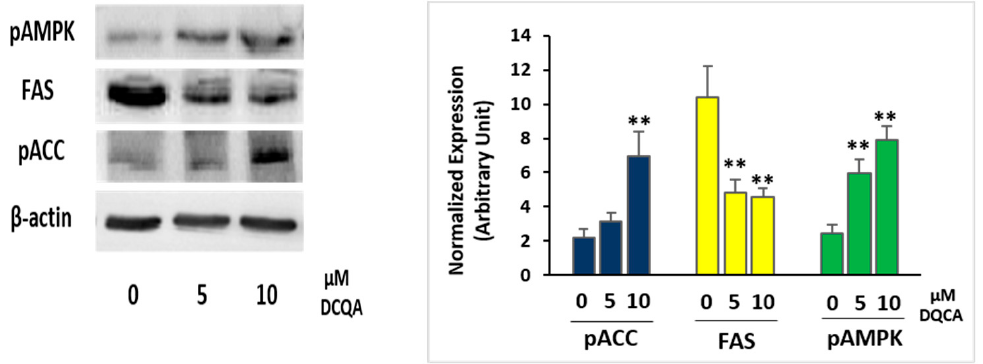
Figure 3. Immunoblot analysis of enzyme involved in the lipid accumulation. 3T3-L1 cells were induced with MDI and treated with or without 5 or 10 µ M DCQA for 10 days. At the time of terminal differentiation, cells were collected and immunoblot was performed as described. On the left, a representative experiment is shown. On the right, the quantification of protein expression of three independent experiments is shown. Data from densitometric analyses were normalized with the β -actin expression. Data statistically significant vs. each control sample are indicated. (** p < 0.01).